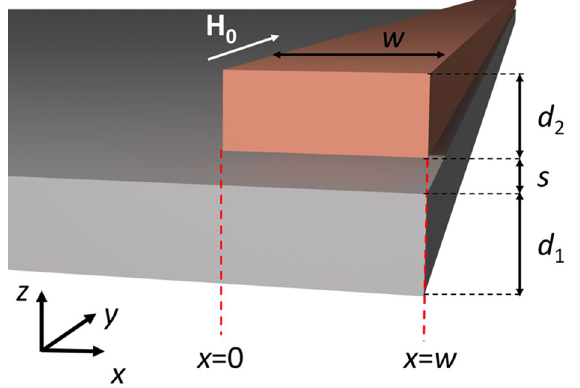
Figure 1. Geometry of the system used in simulations. A ferromagnetic stripe of width w and thickness d 2 is separated from a semi-infinite permalloy film of thickness d 1 by a distance s . The right edges of both layers are aligned at x = w . The whole system is placed in an external magnetic field µ 0 H 0 = 0.1 T parallel to the y axis. The geometry of the system is independent from y